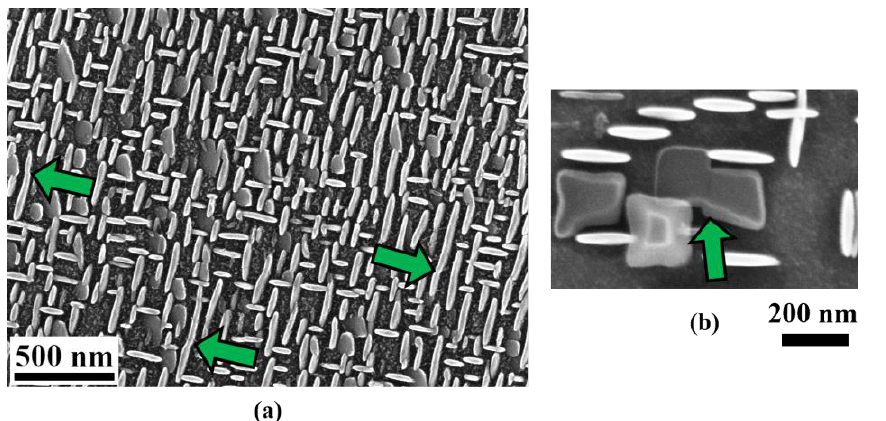
Figure 14. Combination of the γ′′ particles often occurs in planar directions when the volume fraction of the γ′′ phase is very high (see the arrows). ( a ) Normal direction of the γ′′ particles lie in the image plane; ( b ) normal direction of the γ′′ particle is perpendicular to the image plane.